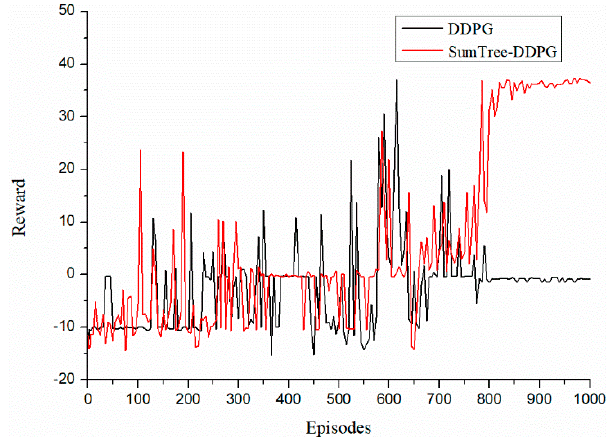
Figure 11. Total reward per episode of AUV training in Environment 1.